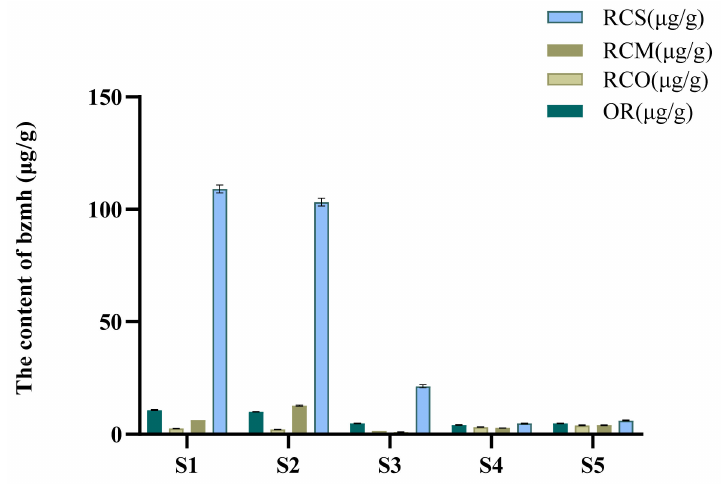
Figure 5. Contents of bzmh in OR, RCO, RCM, and RCS from five Rana chensinensis samples.